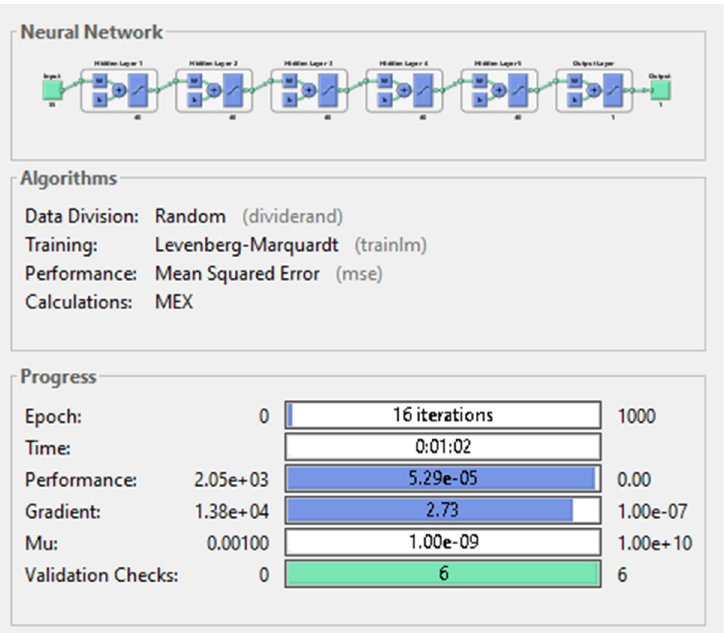
Figure 13. Deep neural network with 5 hidden-layers and 40 neurons on each layer.